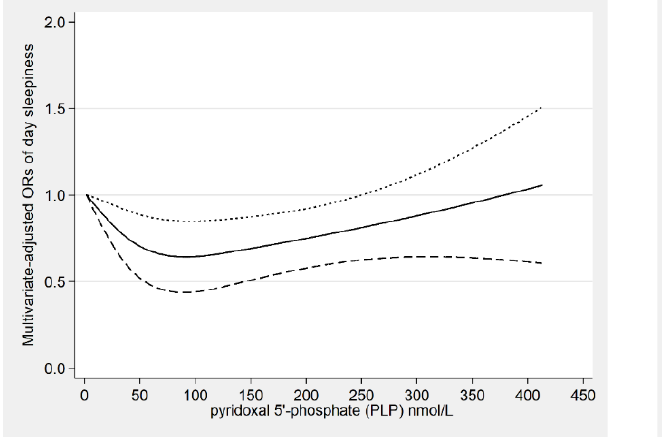
7 of 13 Table 3. Weighted odds ratios (95% confidence intervals) for day sleepiness across quartiles of pyr- idoxal 5 ′ -phosphate (PLP) concentrations stratified by gender (NHANES 2005–2008). Model 2 a Males